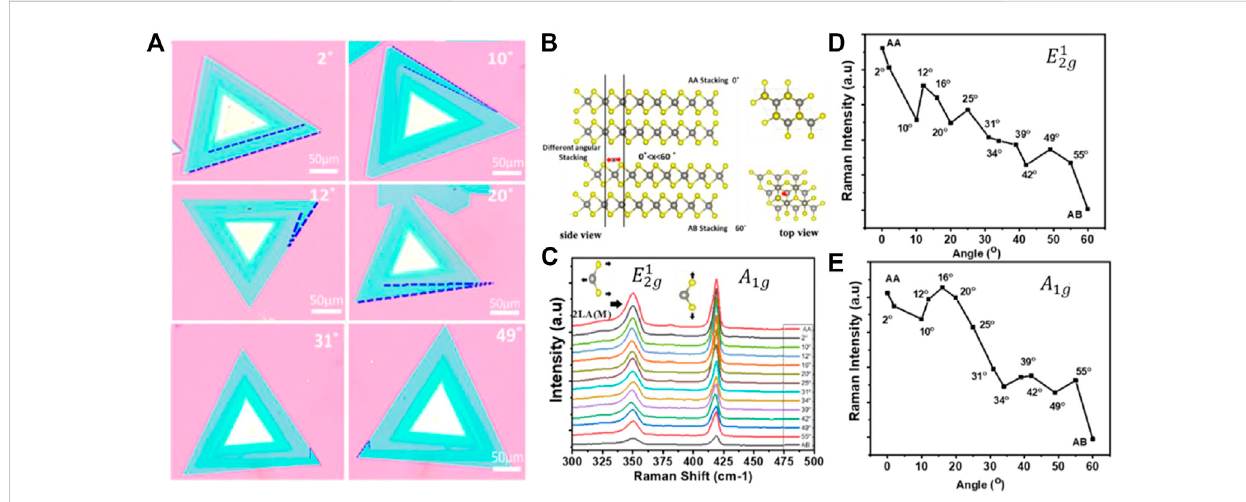
FIGURE 4 Twist angle-dependent responses bilayer WS 2 crystals with different twist angles. (A) Optical images and (B) atomic structure of different angles